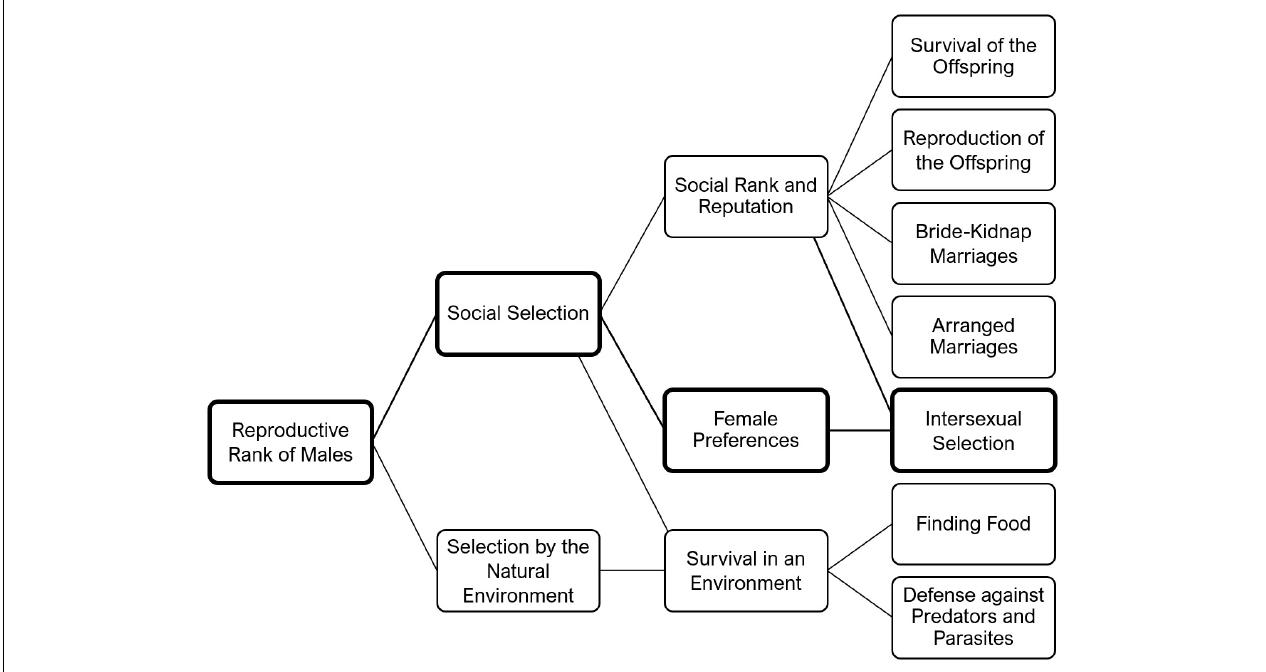
FIGURE 3 | Reproductive rank of males in small-scale societies: The figure shows that there are many factors contributing to the reproductive fitness of males, and that the force on which the backchannel model is built (intersexual selection) is only one force among many others.